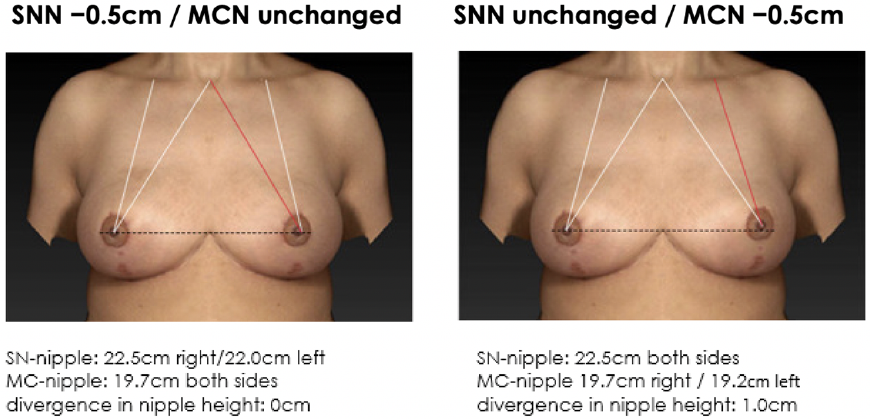
Figure 6. Non-symmetrical mirrored computer-simulated breast models with a modified MC-to- nipple distance and an SSN-to-nipple distance of − 0.5 cm. In total, 47% of the plastic surgeons and 59% of the patients find the image with the unaltered MC-to-nipple distance more attractive than the image with the unaltered SSN-to-nipple distance.